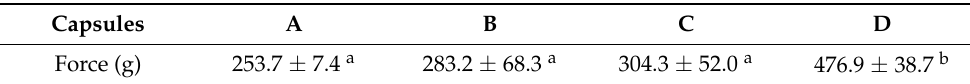
Table 3. Bloom values (g) for the different capsules. Different letters in the same column indicate significant differences ( p <